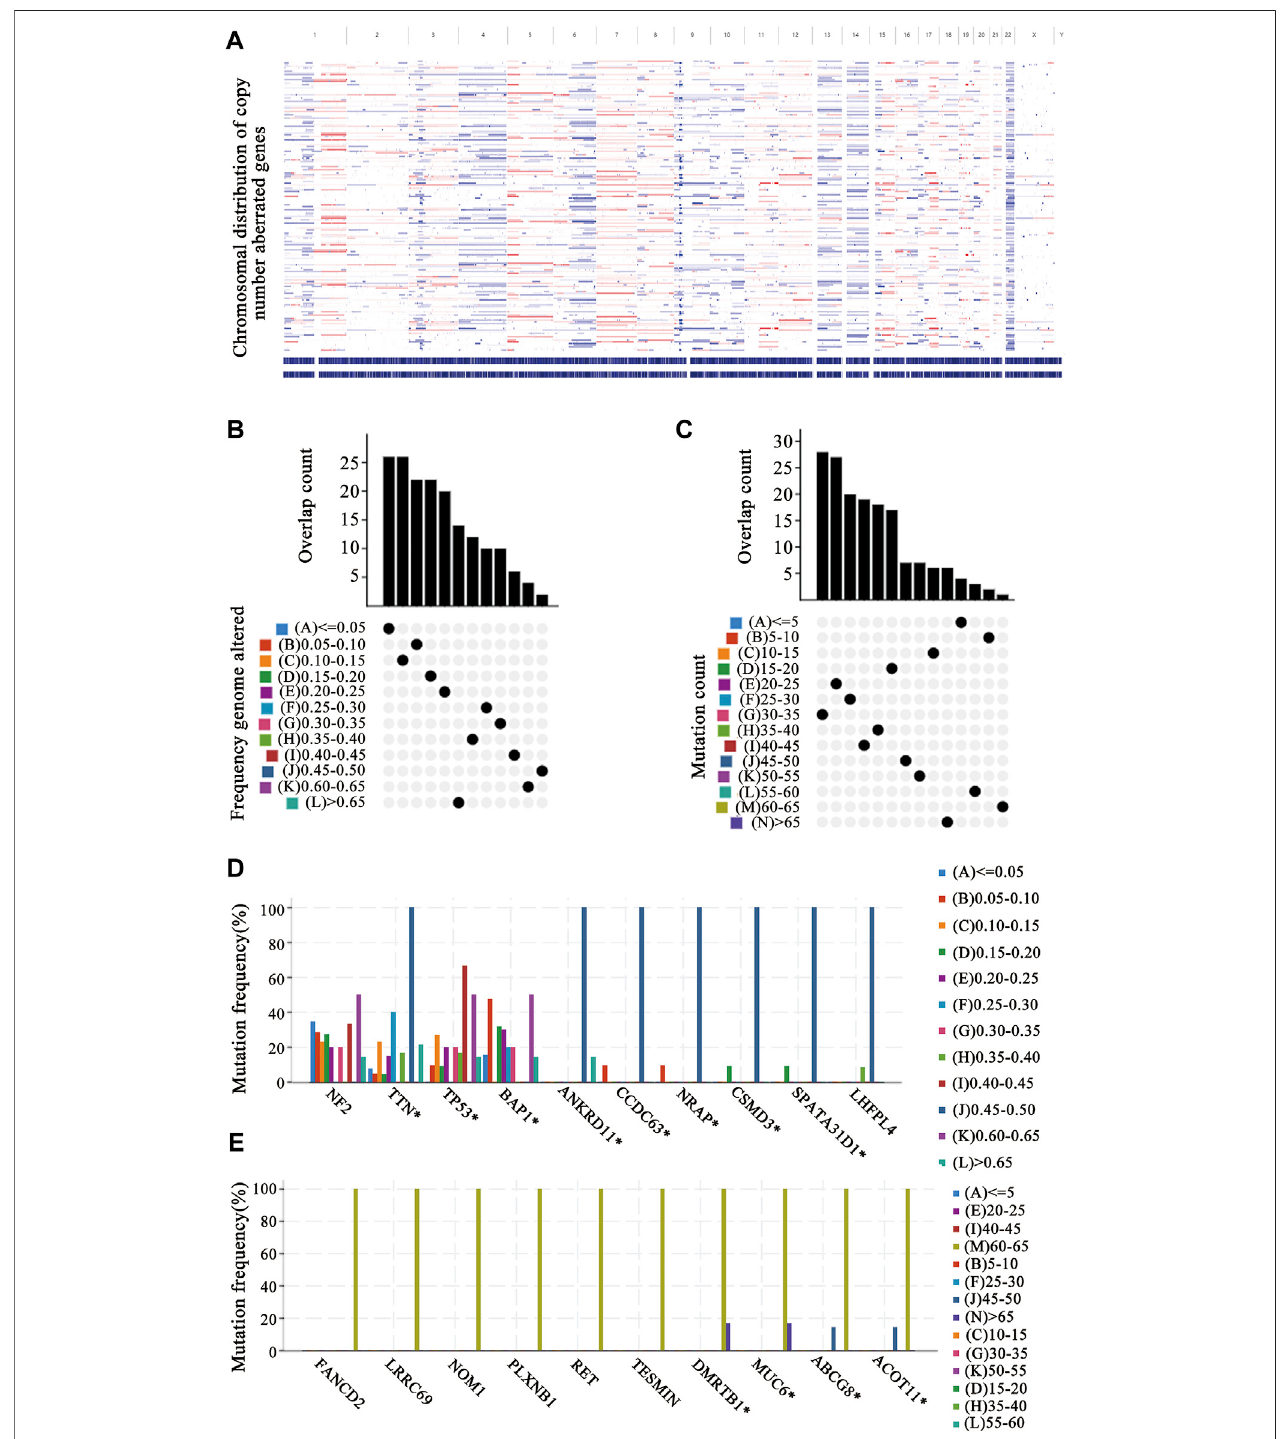
FIGURE1| Identi fi cation oftumor antigencandidates (A) Thedistributionmap ofcopy number aberrant genesonthechromosomes (B – E) Identi fi cationoftumor- speci fi cantigencandidates. The overlapping distribution ofmutated genesinfraction genomealtered groups (B) andmutationcount groups (C) .The highestfrequency genes in altered genome fraction groups (D) and mutation count groups (E) .